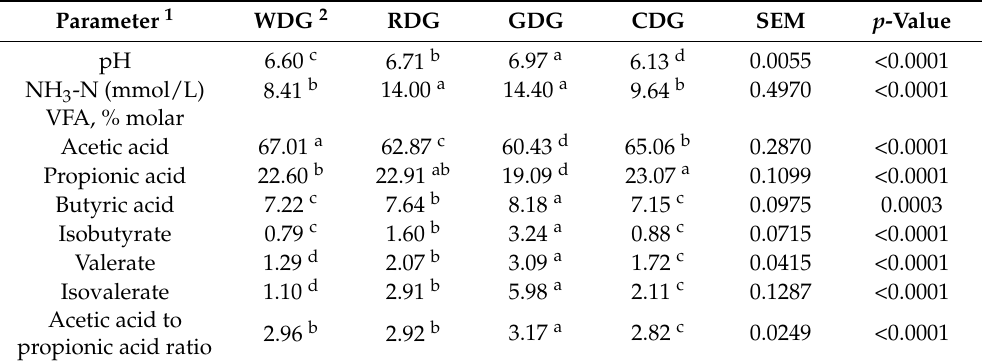
Table 4. Rumen fermentation parameters after 48 h of in vitro ruminal fermentation of four types of distiller’s